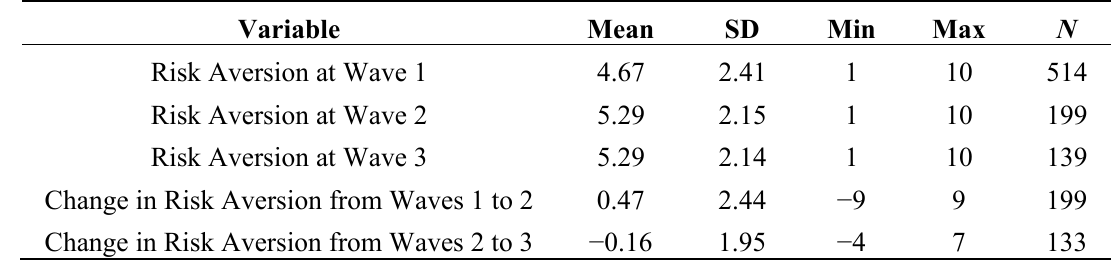
Table 4. Summary statistics of outcome